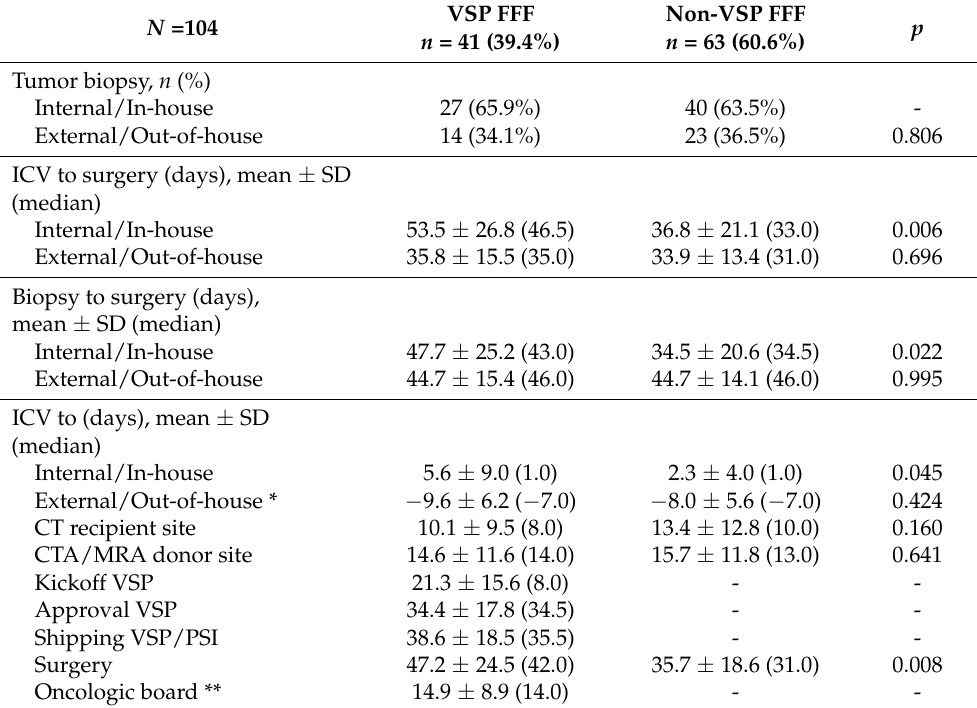
Table 3. Diagnosis, surgery-associated parameters, and comparison of intraoperative